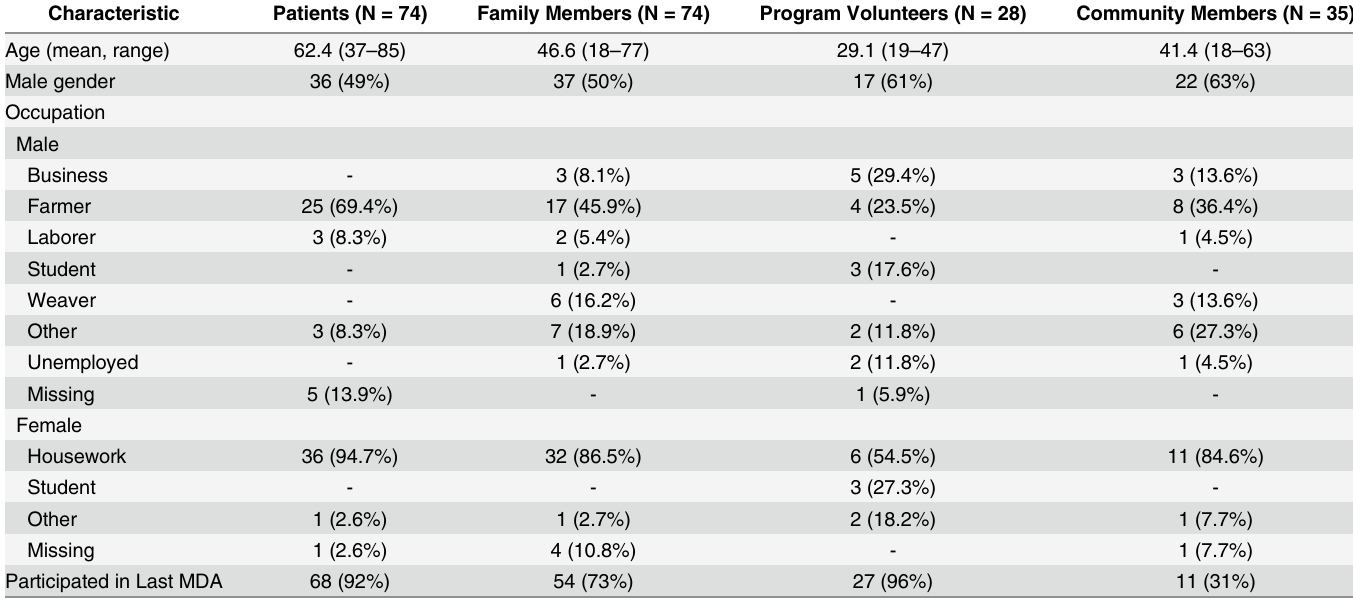
Table 1. Demographic characteristics of focus group participants (N =